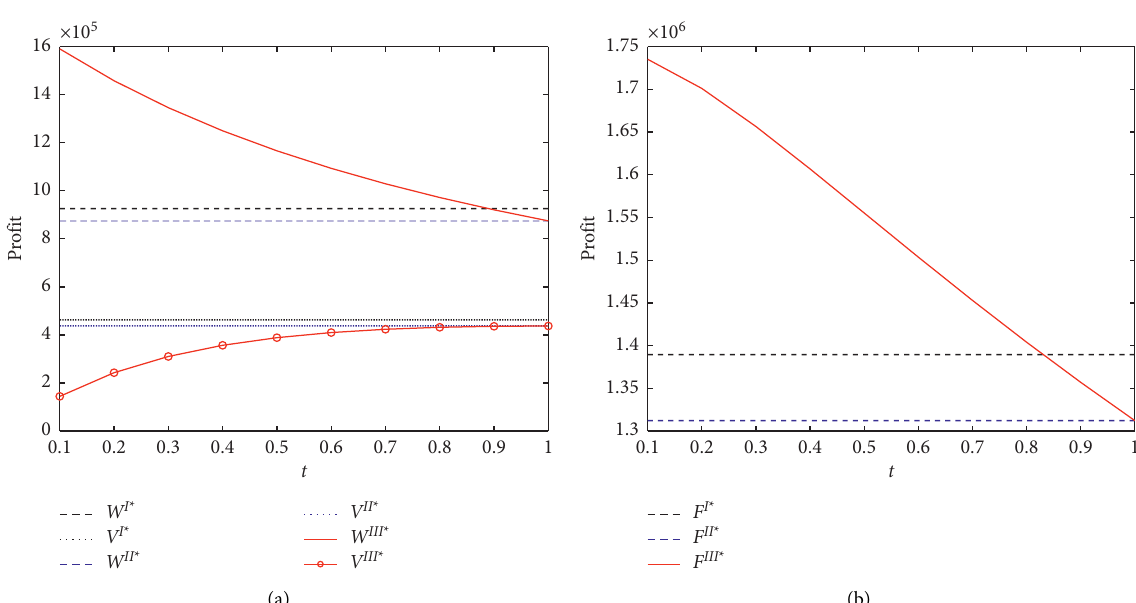
Figure 14: The effects of t on profits. (a) The profits of manufacturer and retailer. (b) The profit of supply chain